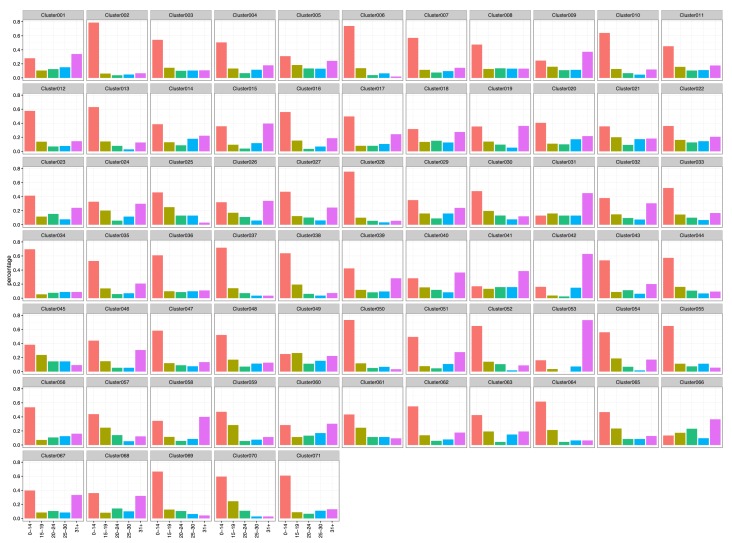
Distribution of duration of diabetes for each cluster.The diabetes duration distribution for individuals in each cluster. Each bar corresponds to a bin for a given interval of the diabetes duration. The height of the bins is the percentage of individuals in the cluster being in that diabetes age bin. The diabetes duration is calculated as the difference in years between diabetes onset and the date for the latest SDCC data entry.